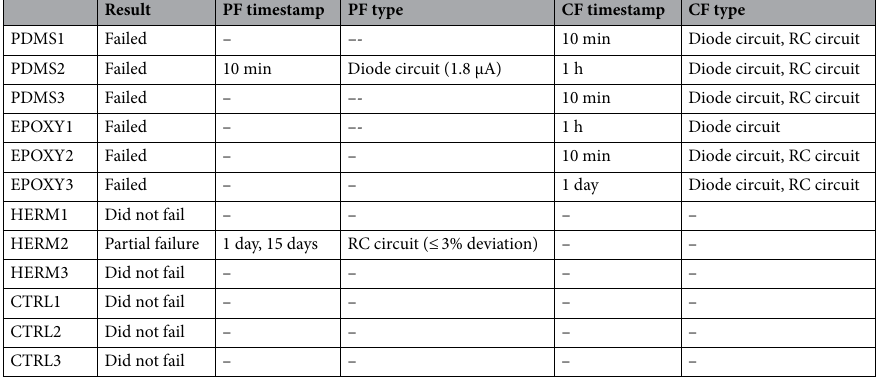
Table 1. Testing results ( PF partial failure, CF complete failure).